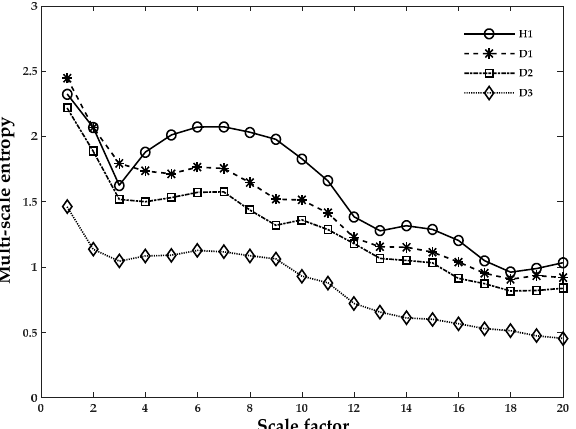
Figure 6. The original REB signal for Case 1. An average of eight segments were in each set. Scale factor 20 vs. multi-scale values (sample entropy) were used to obtain the results of the MSE technique.